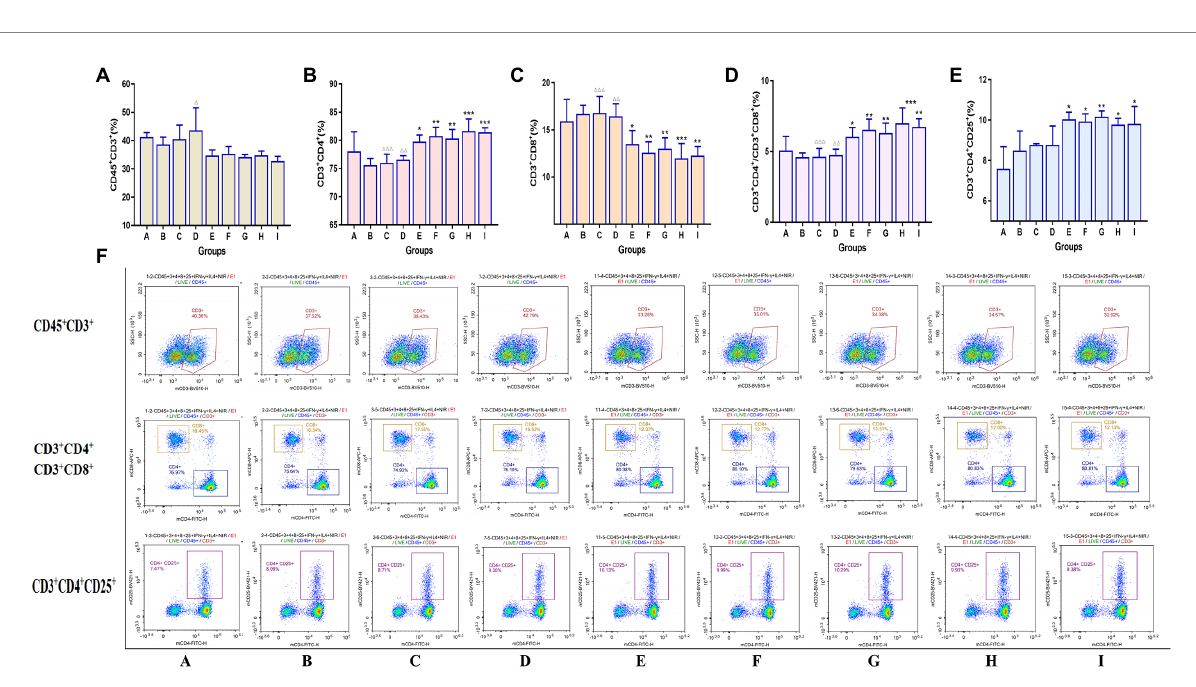
FIGURE 6 Changes in the expression of the Spleen T lymphocyte immunophenotype between groups detected by flow cytometry assay. (A) CD45 + CD3 + ; (B) CD3 + CD4 + ; (C) CD3 + CD8 + ; (D) CD3 + CD4 + /CD3 + CD8 + ; (E) CD3 + CD4 + CD25 + ; (F) representative flow cytometry plots of each detected T lymphocyte. A significant differences were defined between the influenza vaccination alone group and other vaccination groups (* p < 0.05, ** p < 0.01, *** p < 0.001), and between the influenza vaccine and Astragali Radix co-immunized group and other TCM-adjuvant groups ( △△ p < 0.01, △△△ p <